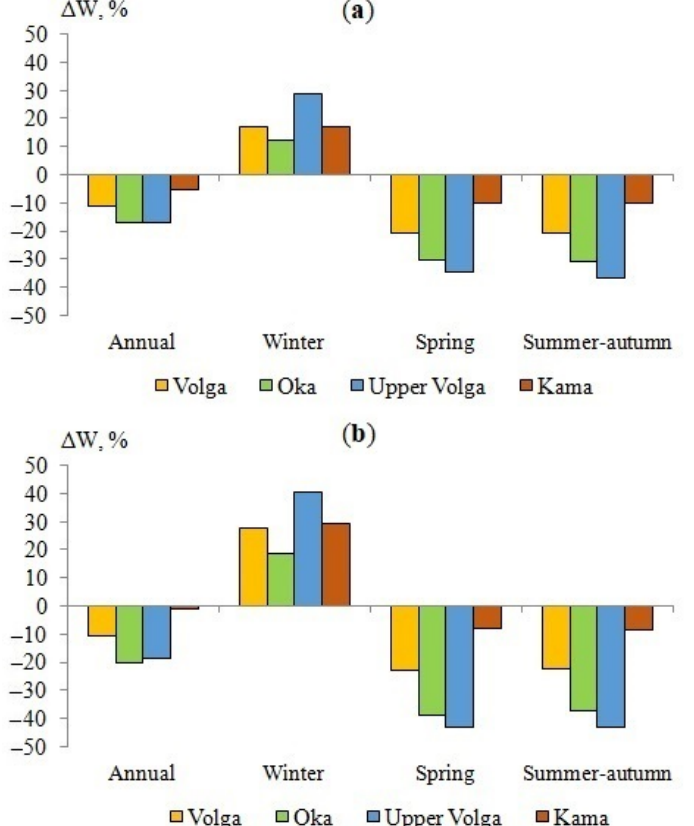
Figure 10. Anomalies of annual and seasonal runoff of the Volga, Oka, Upper Volga and Kama under global warming by 1.5 °C ( a ) and 2 °C ( b ) in the 21st century relative to the baseline period 1970–1999.